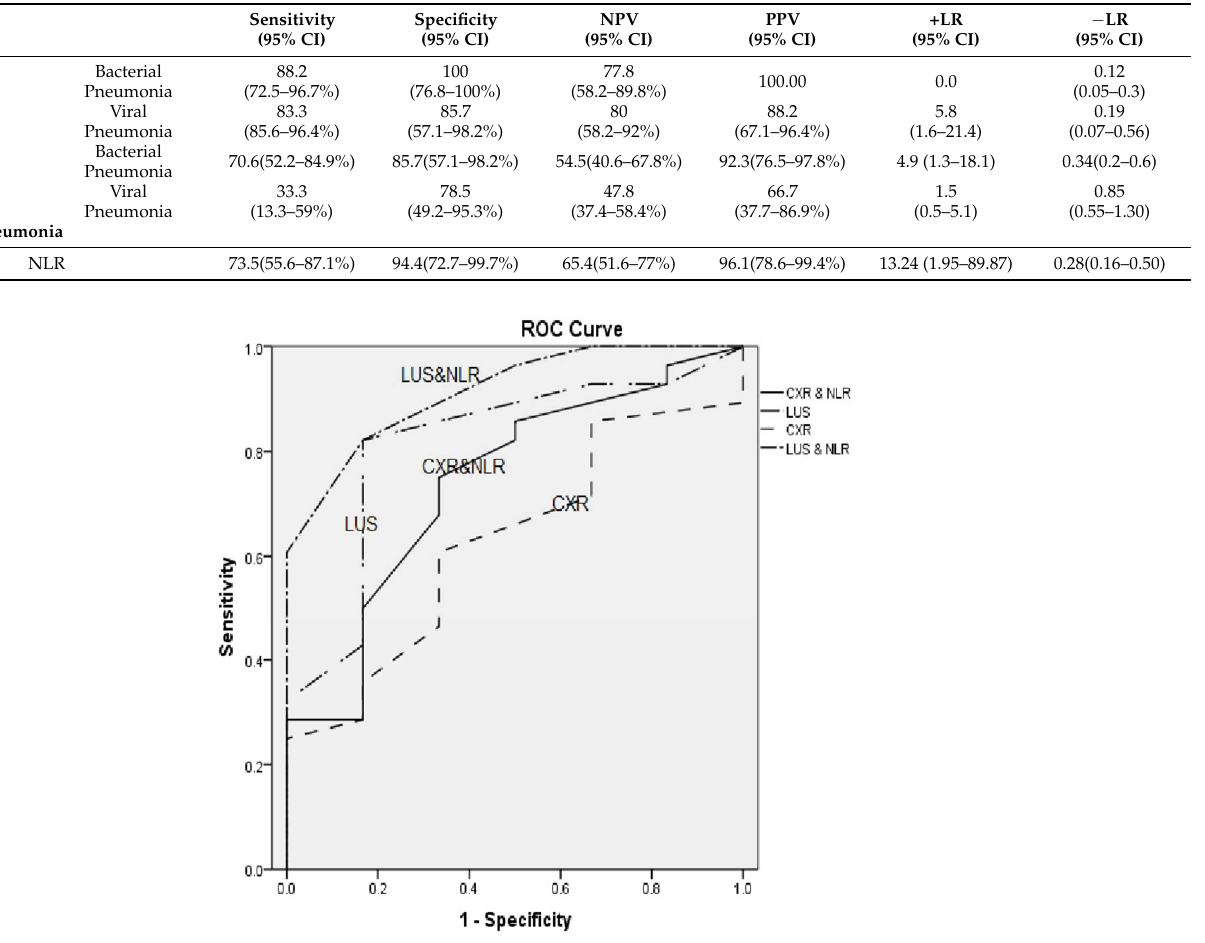
Figure 4. ROC curves for CXR, CXR + NLR, LUS and LUS + NLR. 3.5. Sensitivity, Specificity, PPV and NPV for Each CXR and LUS Findings Regarding the diagnostic performance of the individual CXR findings, the highest sensitivity was with the increased bronchovascular markings (82.8%) and reticulonodular opacity (100 %), and the highest specificity was found with consolidation (87.5%) and the air bronchogram (93.5%). As for the individual LUS finding, the highest sensitivity was with B-lines (83.3%), followed by subpleural consolidation (88.2%) and air bronchograms (88.2%), and the highest specificity was for air bronchograms (94.4%) followed by reduced lung sliding (88.9%) and B-lines (88.2%) (Table 4). Table 4. Sensitivity, specificity, PPV and NPV for each CXR and LUS finding.